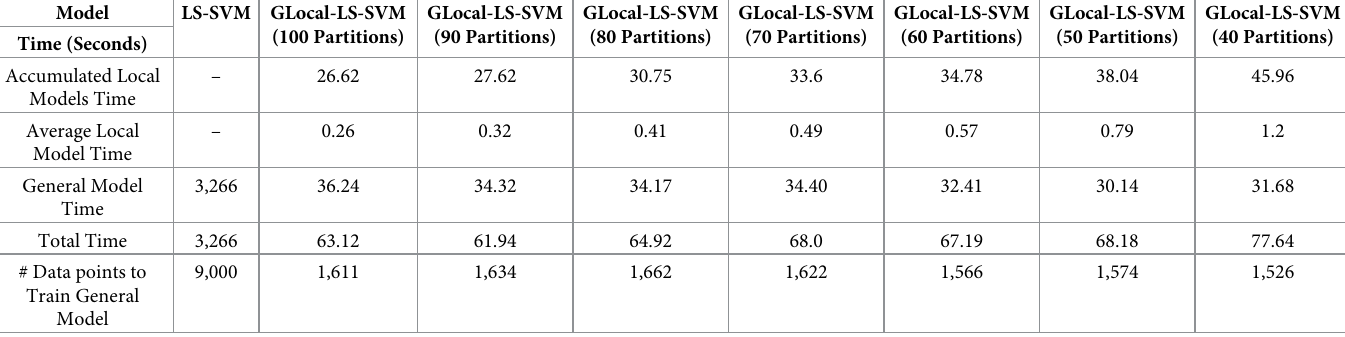
Table 3. Comparing the average time performance, in seconds, of the global LS-SVM model to the GLocal-LS-SVM models (100-40 Partitions), in addition to com- paring the number of the average data points used to train the general model. Model